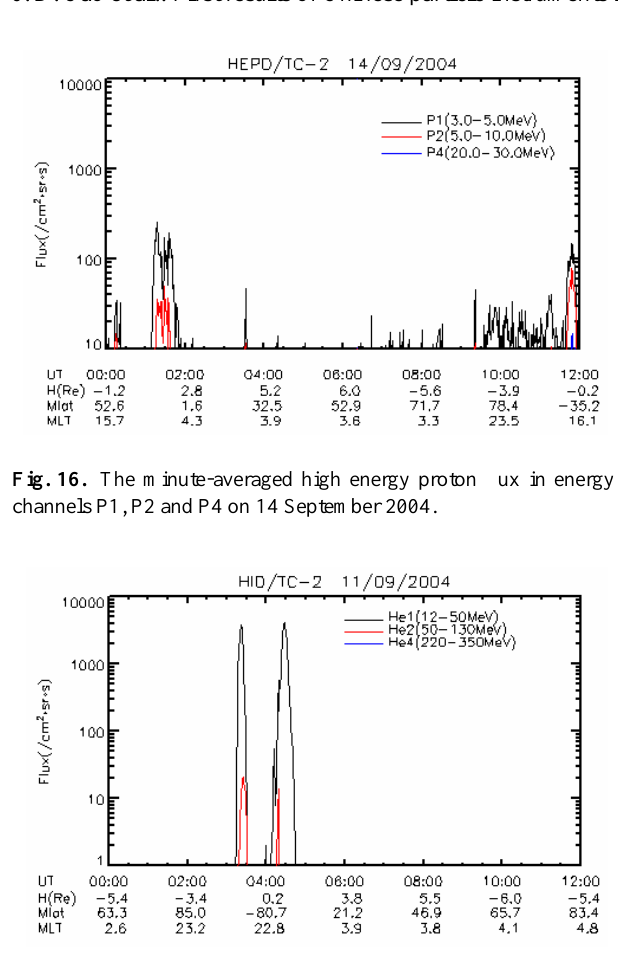
Fig. 17. The minute-averaged helium ion flux in energy channels He1, He2 and He4 observed by HID on 11 September 2004 (a quiet time).